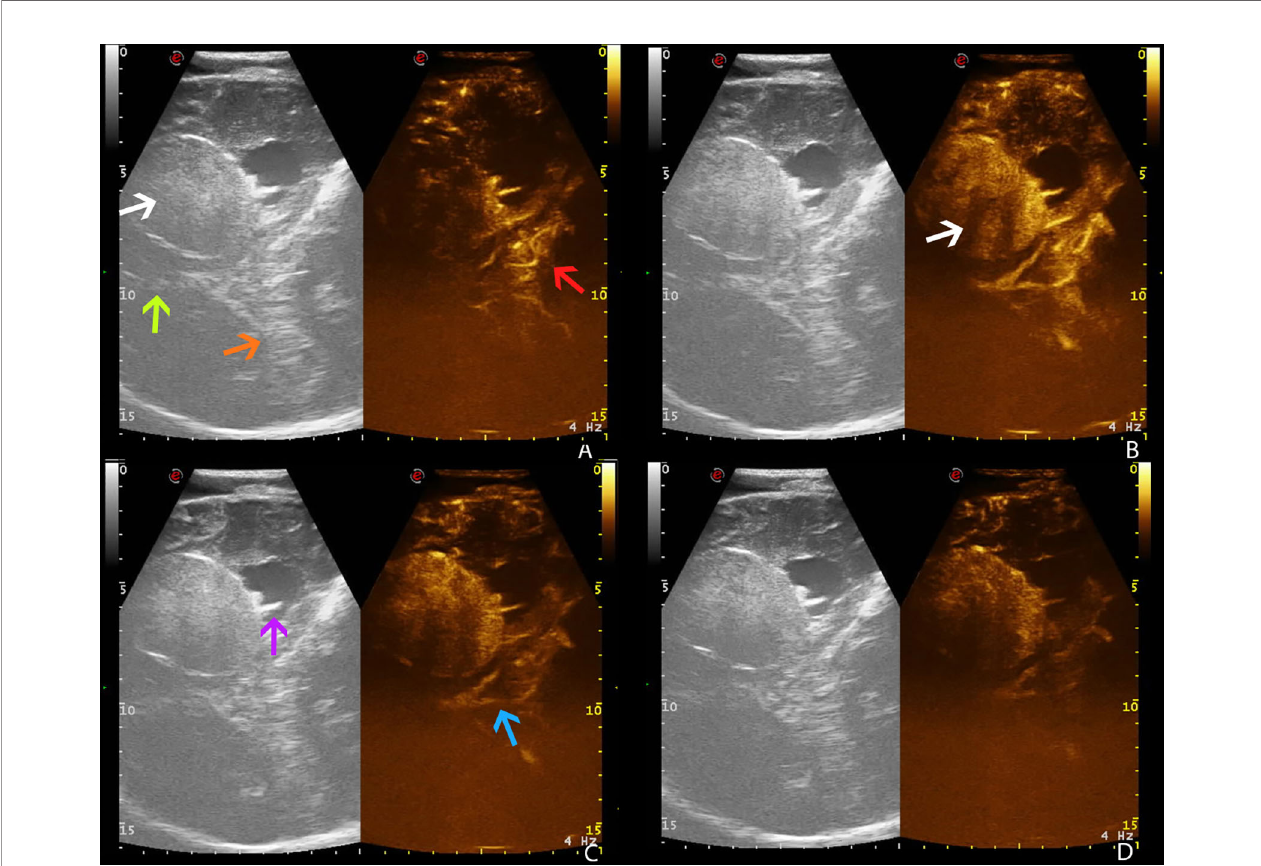
FIGURE 4 | Preoperative time frame of different CEUS phases in a right temporo-parietal fi brous meningioma (case no. 5, Pre-op), using a former iatrogenic skull defect as an optimal acoustic window. (A) Arterial phase. (B) CE peak. (C) Parenchymal phase. (D) Venous phase. White arrow: fi brous meningioma. Green arrow: falx cerebri. Orange arrow: tentorium cerebelli. Red arrow: arterial supply. Purple arrow: choroidal plexus of right lateral ventricle. Blue arrow: deep venous